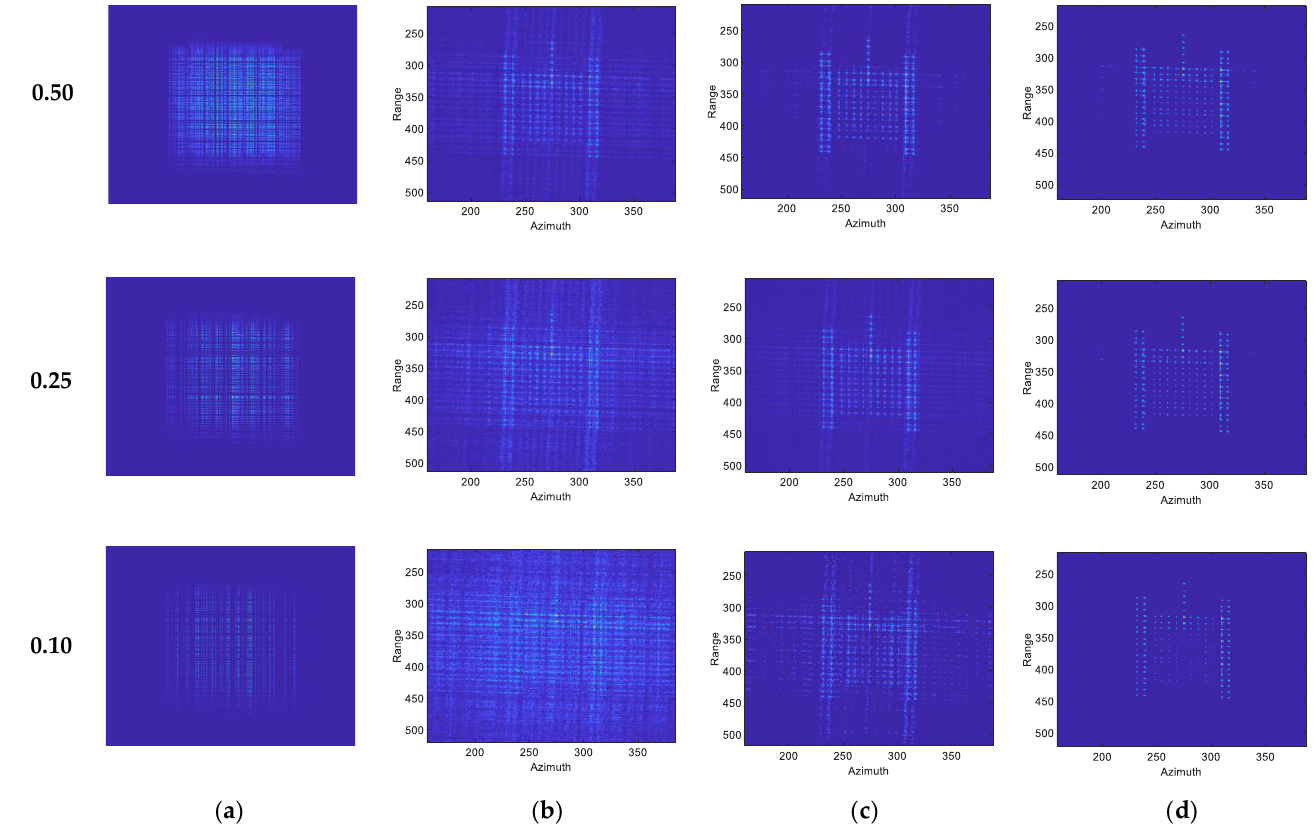
Figure 5. Imaging results of three methods with different sampling ratios. ( a ) SAR-GMT echo signals with different sampling ratios; ( b ) Imaging results of the method in [8]; ( c ) Imaging results of the method in [17]; ( d ) Imaging results of the proposed method.